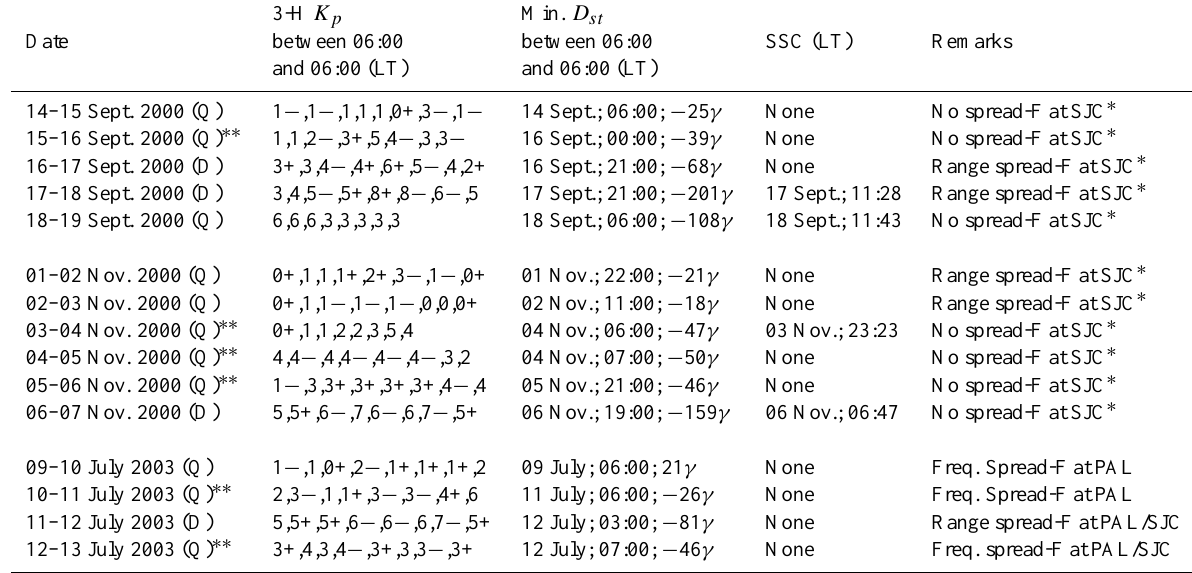
Table 1. Details of magnetic